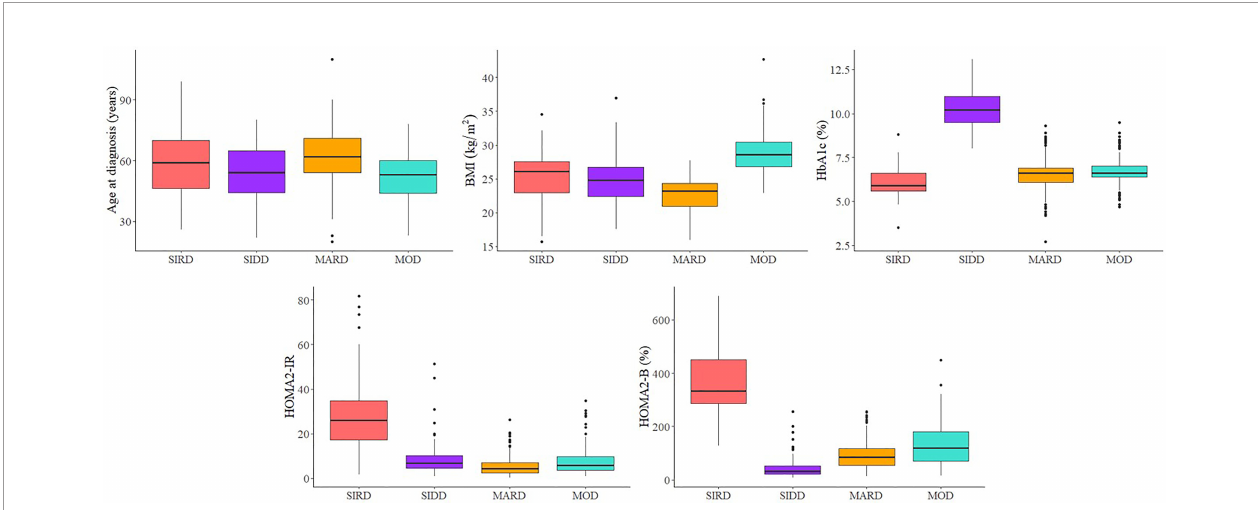
FIGURE 1 | Type 2 diabetes sub-phenotypes characteristics. SIRD, severe insulin-resistant diabetes; SIDD, severe insulin-de fi cient diabetes; MARD, mild age- related diabetes; MOD, mild obesity-related